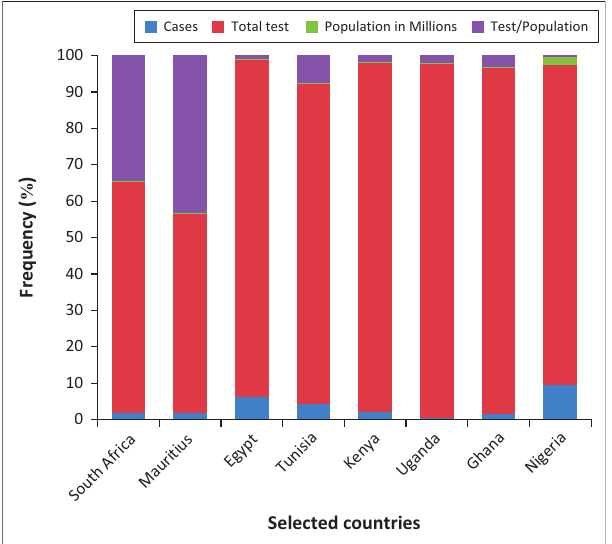
FIGURE 1: Distribution of severe acute respiratory syndrome coronavirus-2 burden and test per population in selected African